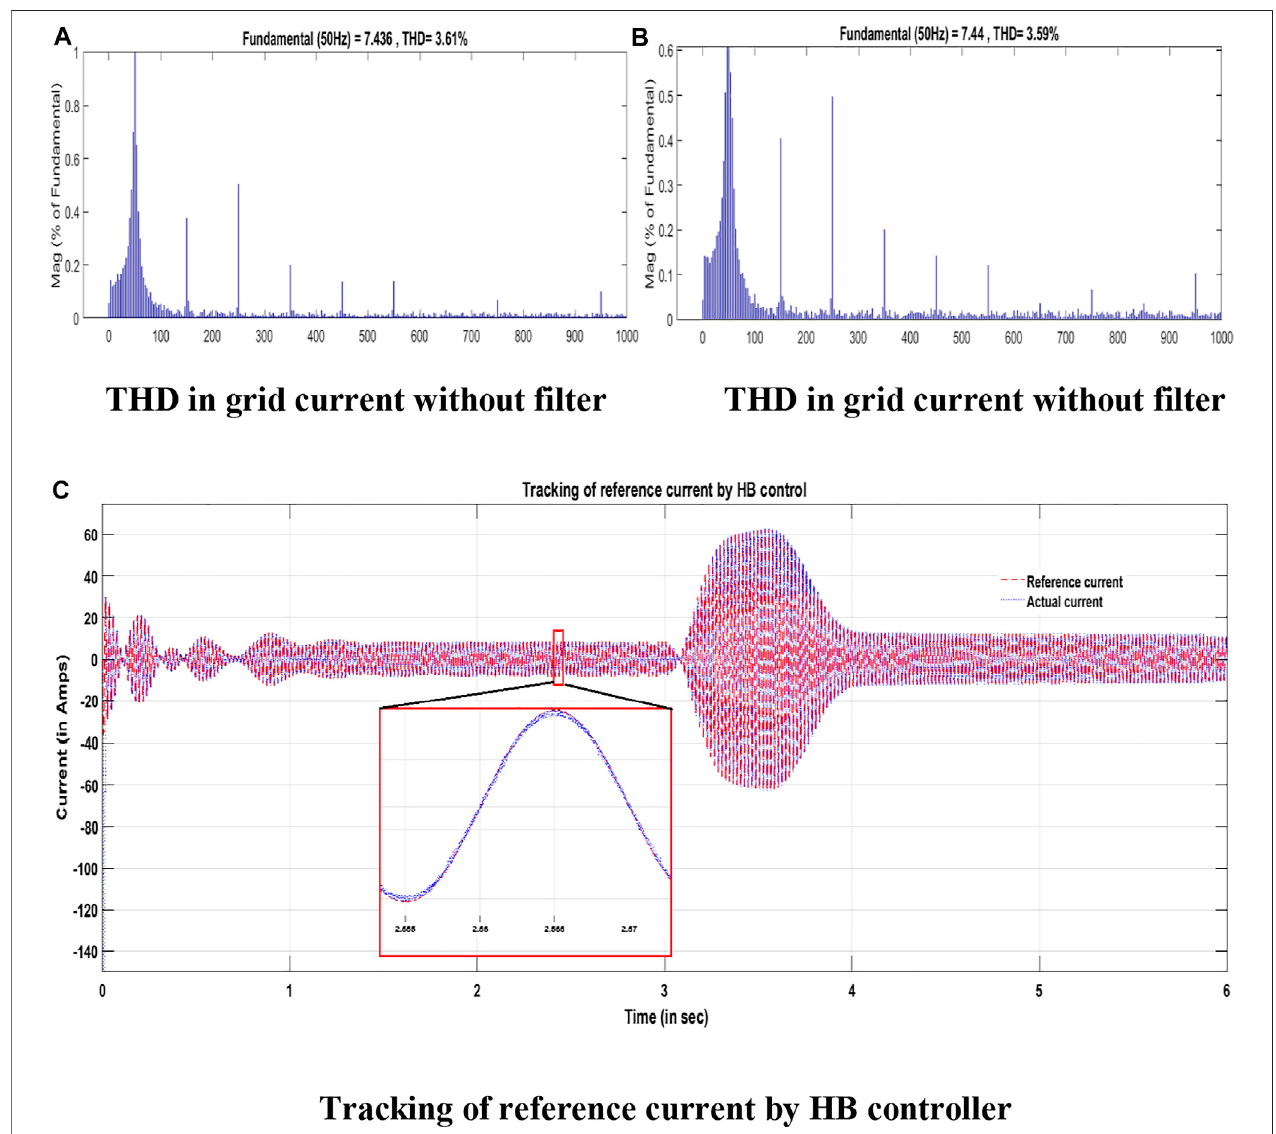
FIGURE 5 | (A) THD in grid current without fi lter (B) THD in grid current without fi lter. (C) Tracking of reference current by HB controller.